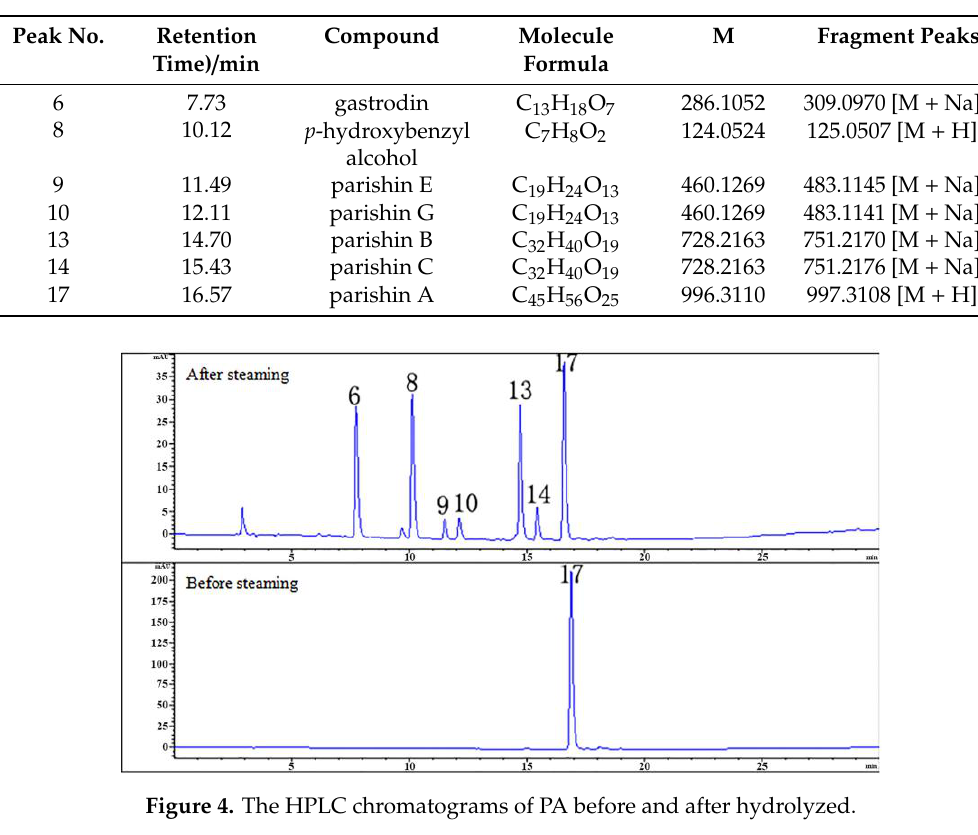
Table 3. ESI-TOF / MS accurate mass measurements of seven compounds in samples.